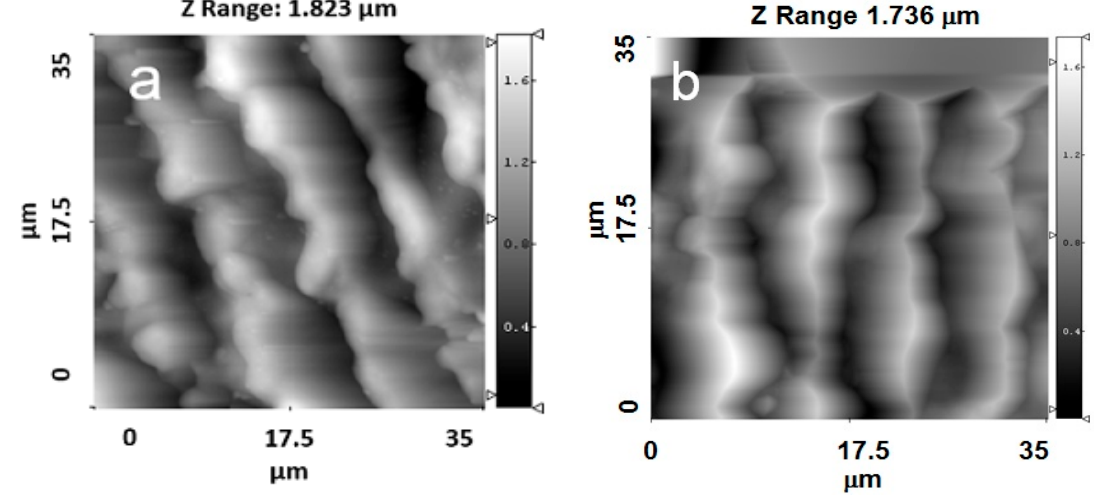
Figure 4. AFM images of the topographies of Ti samples with parallel grooves with a periodicity of approximately 8.4 µ m. ( a ) 35 × 35 µ m 2 ; ( b ) 35 × 35 µ m 2 with a HA film.